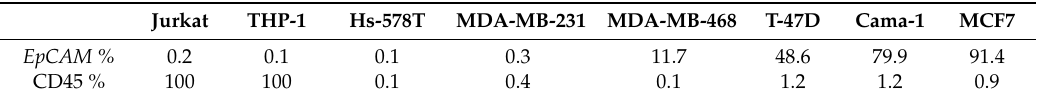
Table 1. EpCAM and CD45 expression on different cancer cell lines were analyzed with flow cytometry. The results are from one representative experiment out of three, and the results are presented as % positive cells.